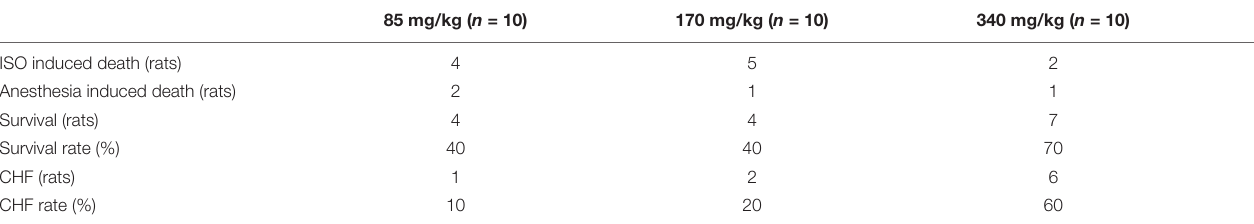
TABLE 1 | CHF rate and survival rate at each dose of ISO.